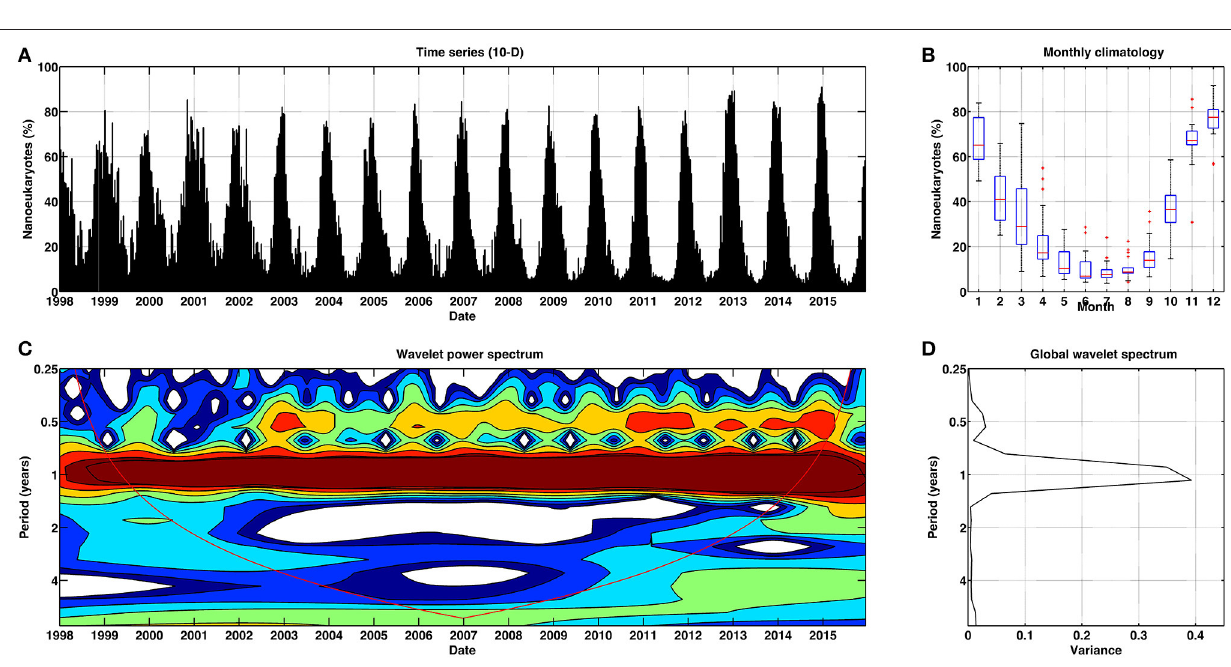
FIGURE 6 | Temporal patterns of variability for nanoeukaryotes for Mediterranean Sea. (A) Temporal percentage (10-day) of nanoeukaryotes. (B) Box plot (red lines stand for the median, blue box spans from the first to the second quartiles, and black lines represent 5th and 95th percentiles, respectively) of monthly climatology of nanoeukaryotes. (C) Continuous wavelet power spectrum for the 10-day time series. Red line indicates the cone of influence, and is the region affected by the edges of the data and should not be considered. (D) Global wavelet spectrum for the 10-day time